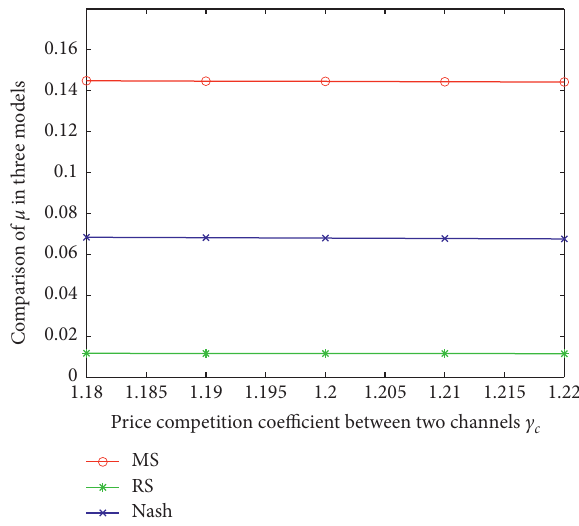
Figure 12: The comparison of the optimal customization level μ in the three models.